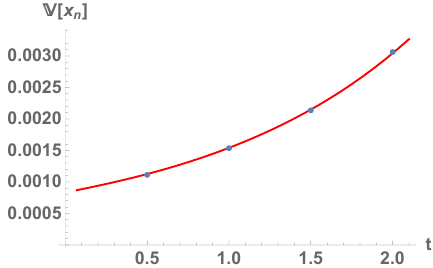
Figure 6. Approximation of the variance with the NSFD scheme, with M = 1 and N = 5 ( h = τ / N ), and comparison with Monte Carlo simulation (circles) using 10,000 realizations. This figure corresponds to Example